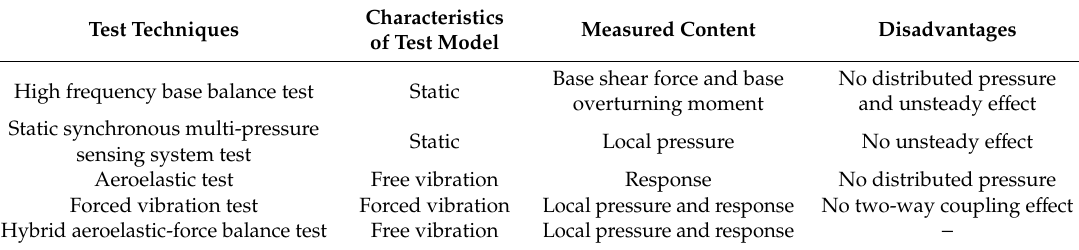
Table 1. Comparisons of each wind tunnel test technique.